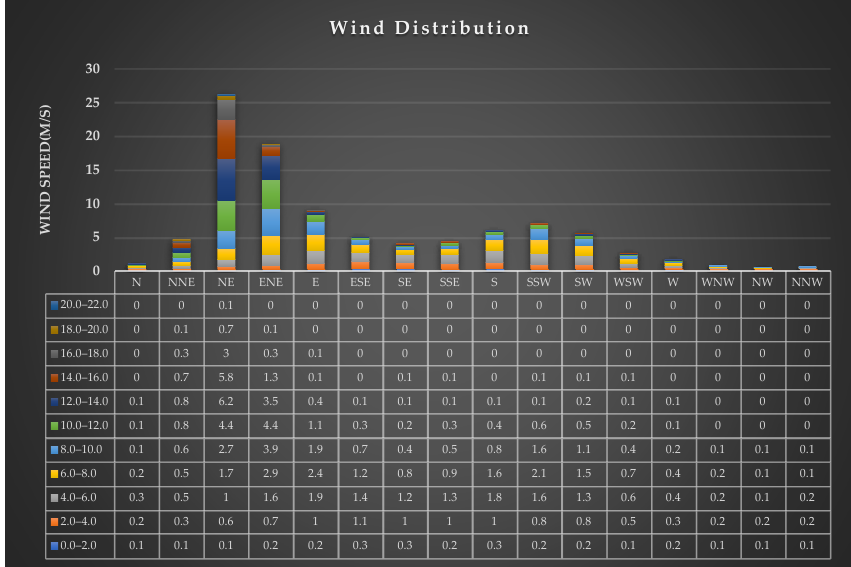
Figure 4. Wind direction and speed distribution for LH11 − 1 FPSO (related to True North).